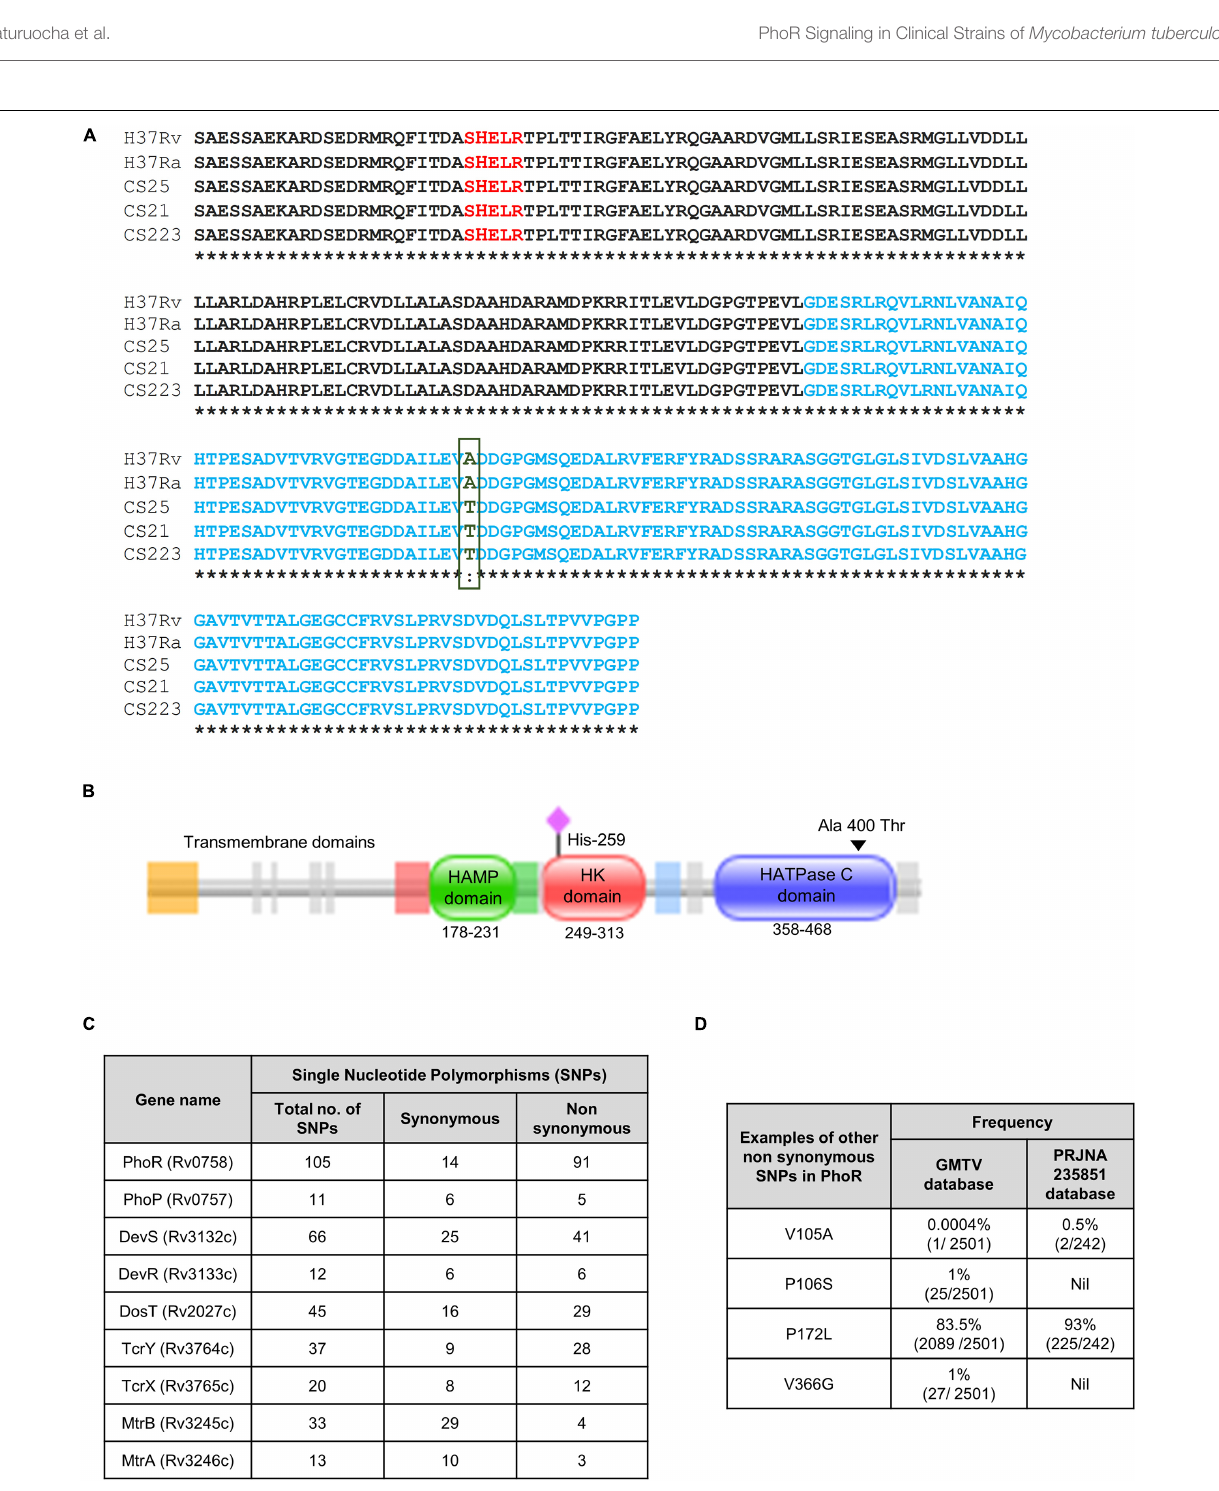
FIGURE 1 | Single-nucleotide polymorphisms (SNPs) in the sensor kinase PhoR and other two-component systems (TCSs) in the clinical strains of Mycobacterium tuberculosis . (A) Sequence alignment of the sensor kinase (SK) protein PhoR, with H37Rv as the reference strain aligned with H37Ra and three clinical strains. HATPase domain is marked in blue with the mutation from alanine to threonine at 400 marked in green. CS25, CS21, and CS223 are the numbers assigned to three of the 223 clinical strains that carry this mutation analyzed in this study. (B) Pfam analysis of the SK protein PhoR from H37Rv, depicting the presence of three distinct domains, the HAMP domain (amino acids 178–231), the histidine kinase (HK) domain (amino acids 249–313), and the HATPase domain (amino acids 358–468). The predicted transmembrane domains are depicted to the left of these domains. The black triangle marks the mutation in the HATPase domain, and the pink diamond marks His 259 , the phosphorylation site. (C) Table showing the frequencies of synonymous and non-synonymous SNPs in various TCS proteins wrt H37Rv as reference genome reported in the GMTV database. (D) Table showing the frequencies of SNPs that are found in the PhoR sensor kinase in GMTV database and PRJNA235851